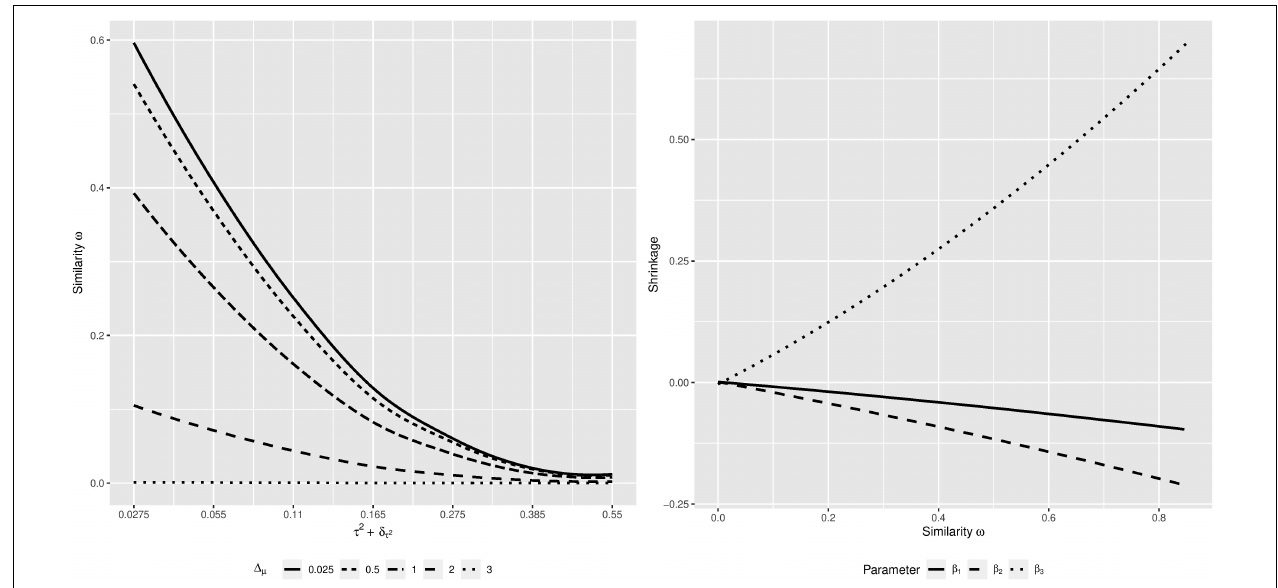
FIGURE 1 | Regression curves of the relation between the similarity measure ω and τ 2 + δ τ 2 for different levels of (cid:52) µ ( left panel ), and the relation between the shrinkage and the similarity measure ω , for each β -parameter ( right panel ), based on estimates from 21,000 simulated